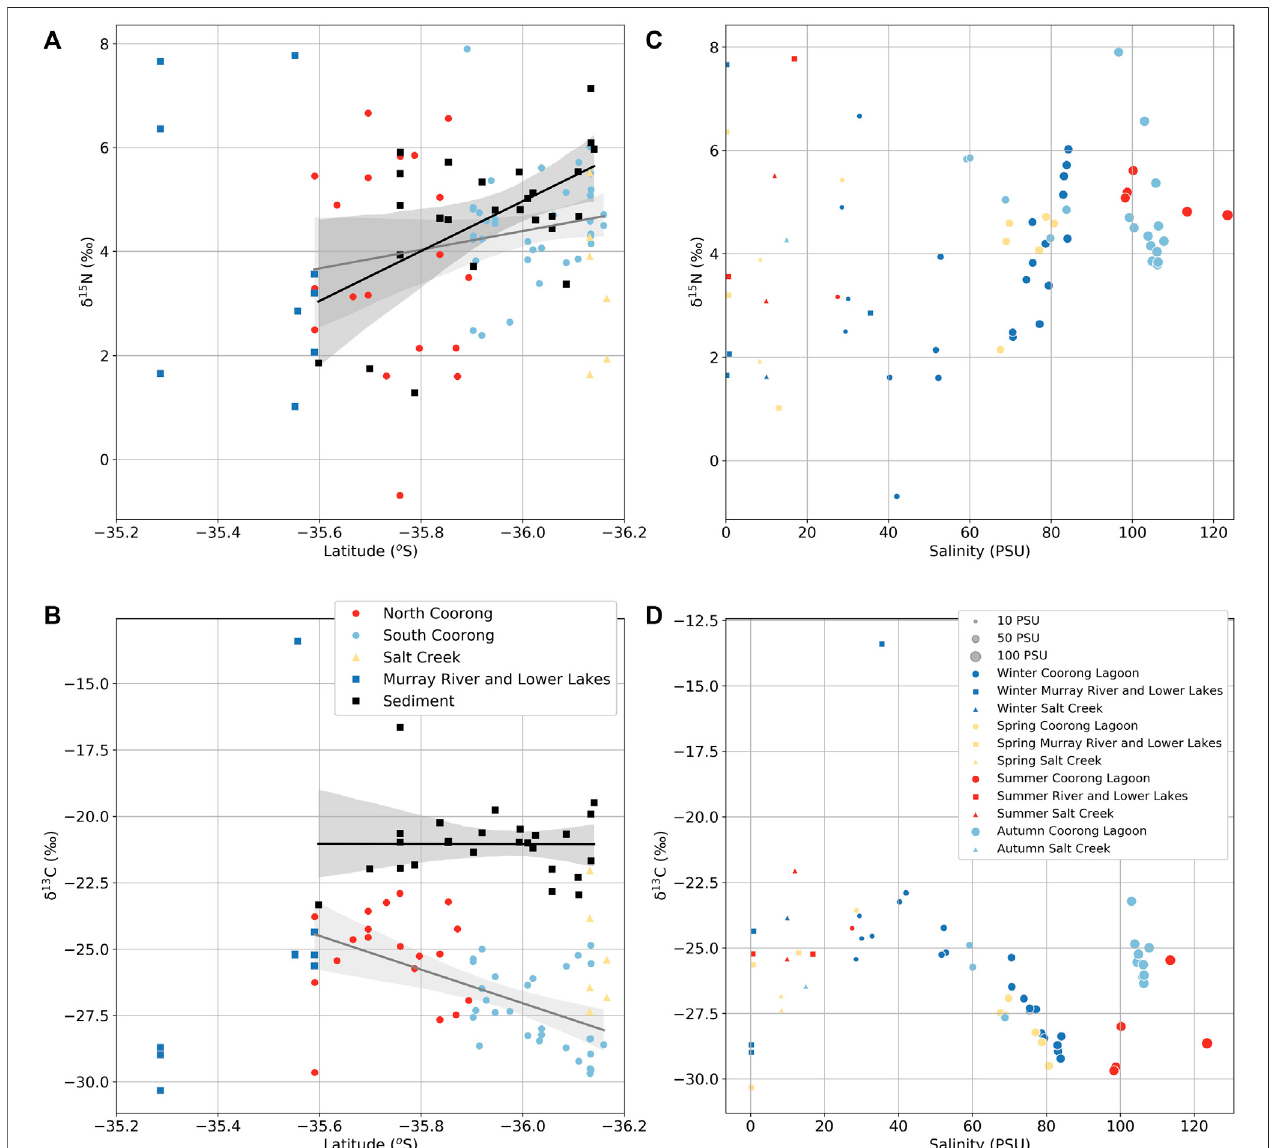
FIGURE 4| (A) PON and bulk sediment δ 15 N results and (B) particulate carbon (PC) and bulk sediment δ 13 Cresults against sample latitude. Legend in (B) applies to (A) as well. (C) δ 15 N PON results and (D) δ 13 C PC results against salinity. In both, the gray regression line represents all Coorong Lagoon POM isotope values and black regression line represents the bulk sediment isotope values. Legend in (D) applies to (C) as